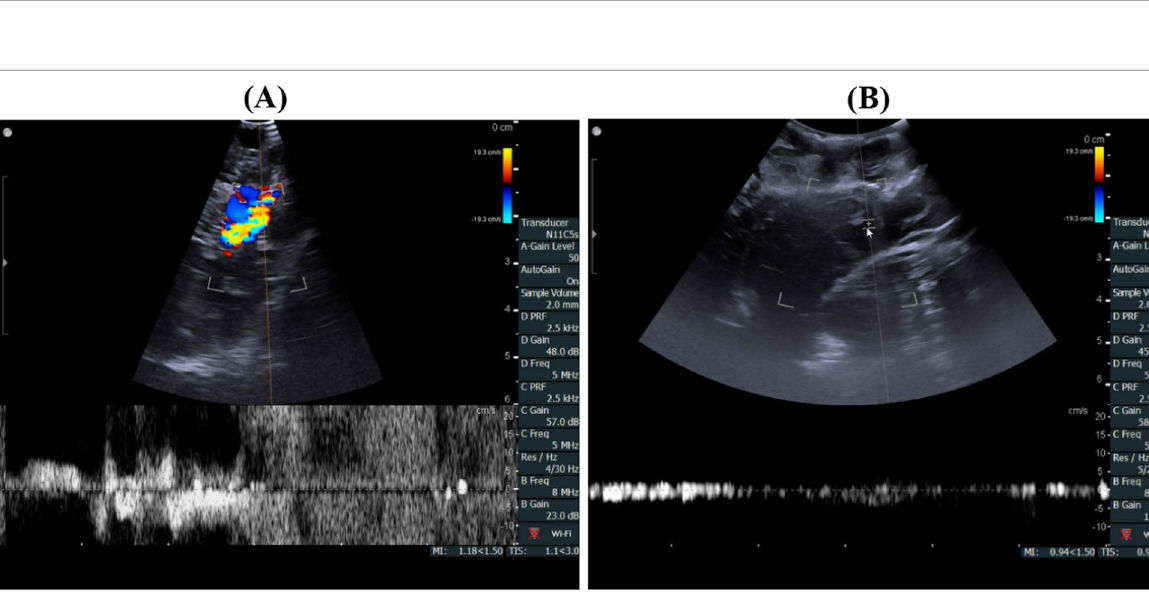
Fig. 7 IOUS of AVM case during and after resection. A during resection, it assesses the extent of resection. It shows smaller size of the lesion than the original size. The resection is then completed to ensure maximum resection. B After resection is completed, no nidus is